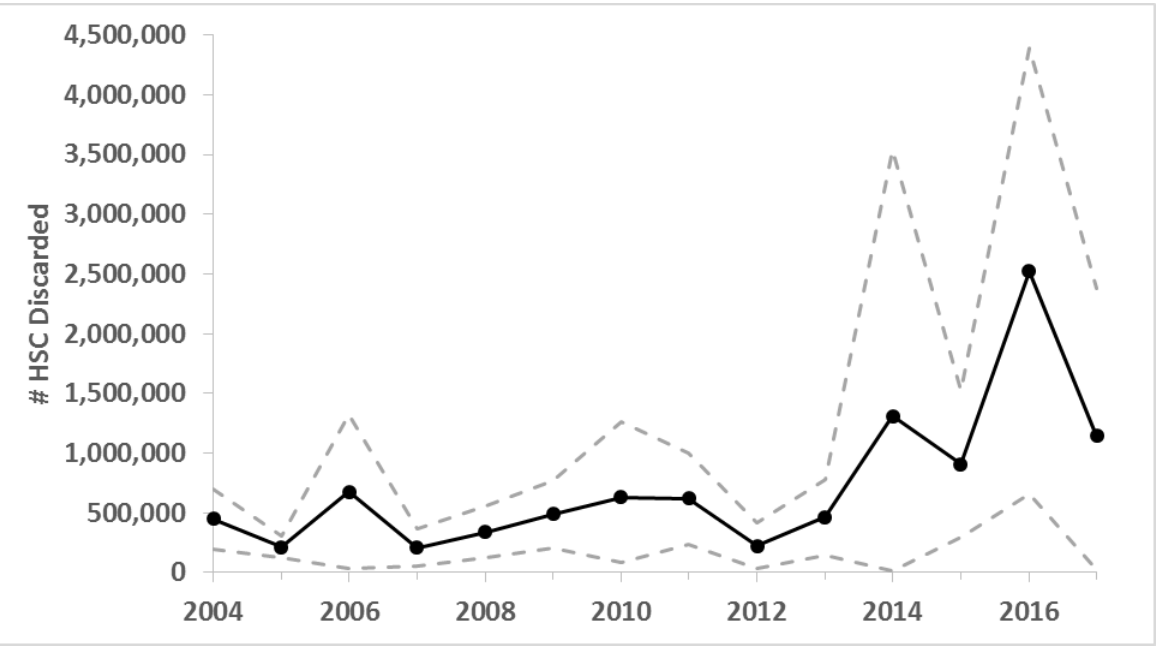
Figure 19. Estimated number of horseshoe crabs discarded from gill nets, trawls, and dredges in the Delaware Bay region, 2004-2017, with 95% confidence